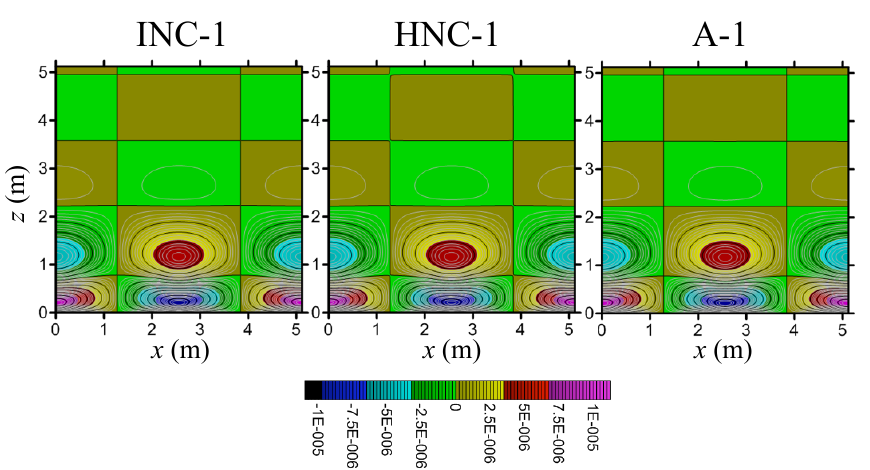
Figure 3. Vertical cross section of u from the first test case. A-1 is the analytical solution. INC-1 is the numerical simulation with inhomoge- neous Neumann condition for pressure. HNC-1 is the numerical simulation with the homogeneous Neumann condition for pressure. Colour bar units are ms − 1 .